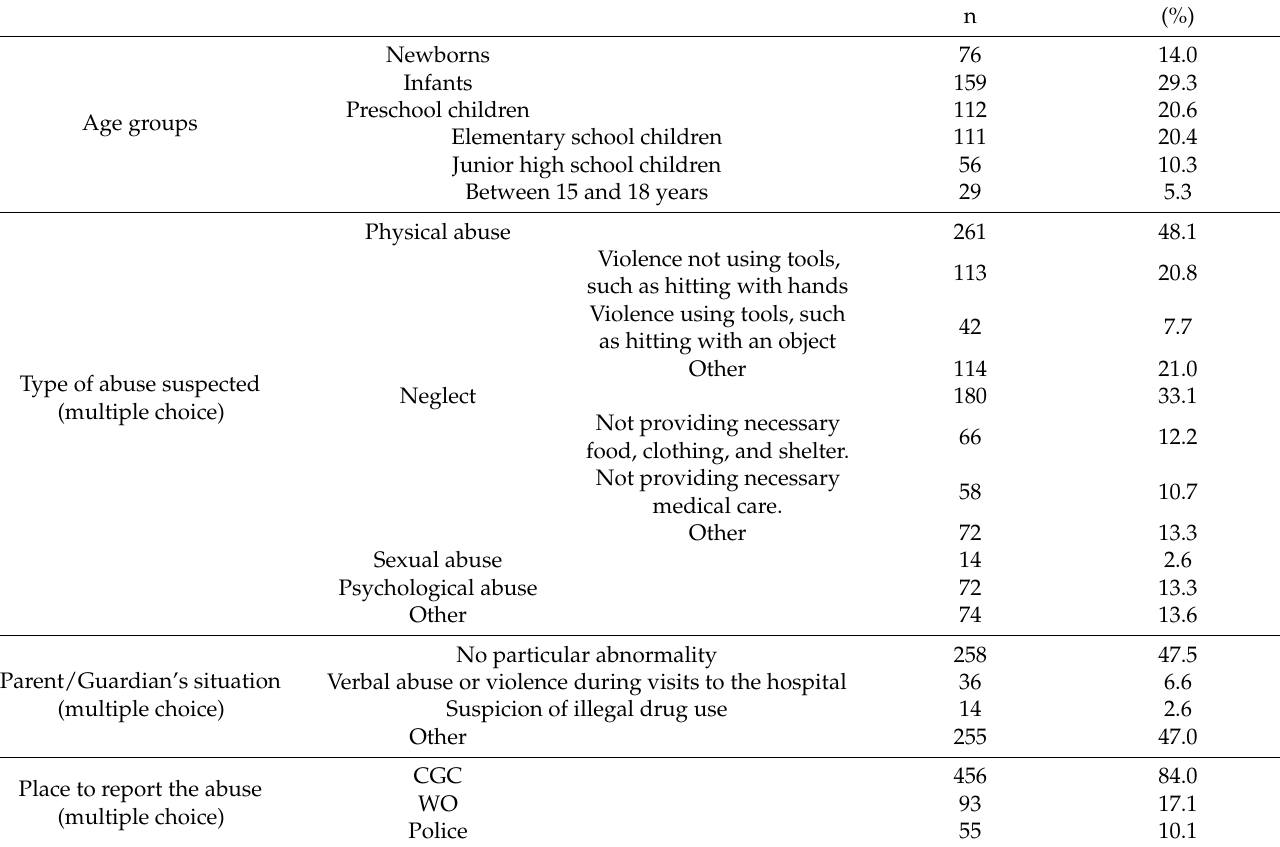
Table 3. Child abuse cases that 223 institutions actually notified or reported in